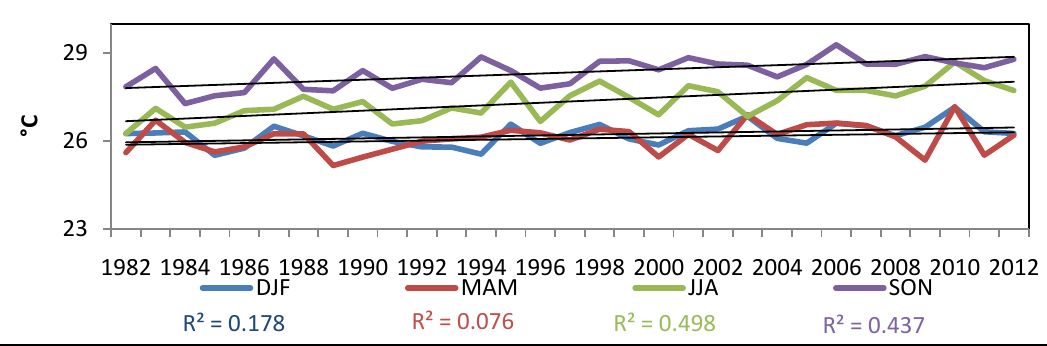
Figure 5. Top Panel: Seasonal Sea Surface Temperature trends (AVHRR Pathfinder v5.2 SST, extracted in a 4x4 km 2 area in the Atlantic Ocean immediately off San Juan 1981–2012). Lower Panel: Number of days showing extremely high SST (above the 90th percentile: 29 °C, and 95th percentile: 29.4